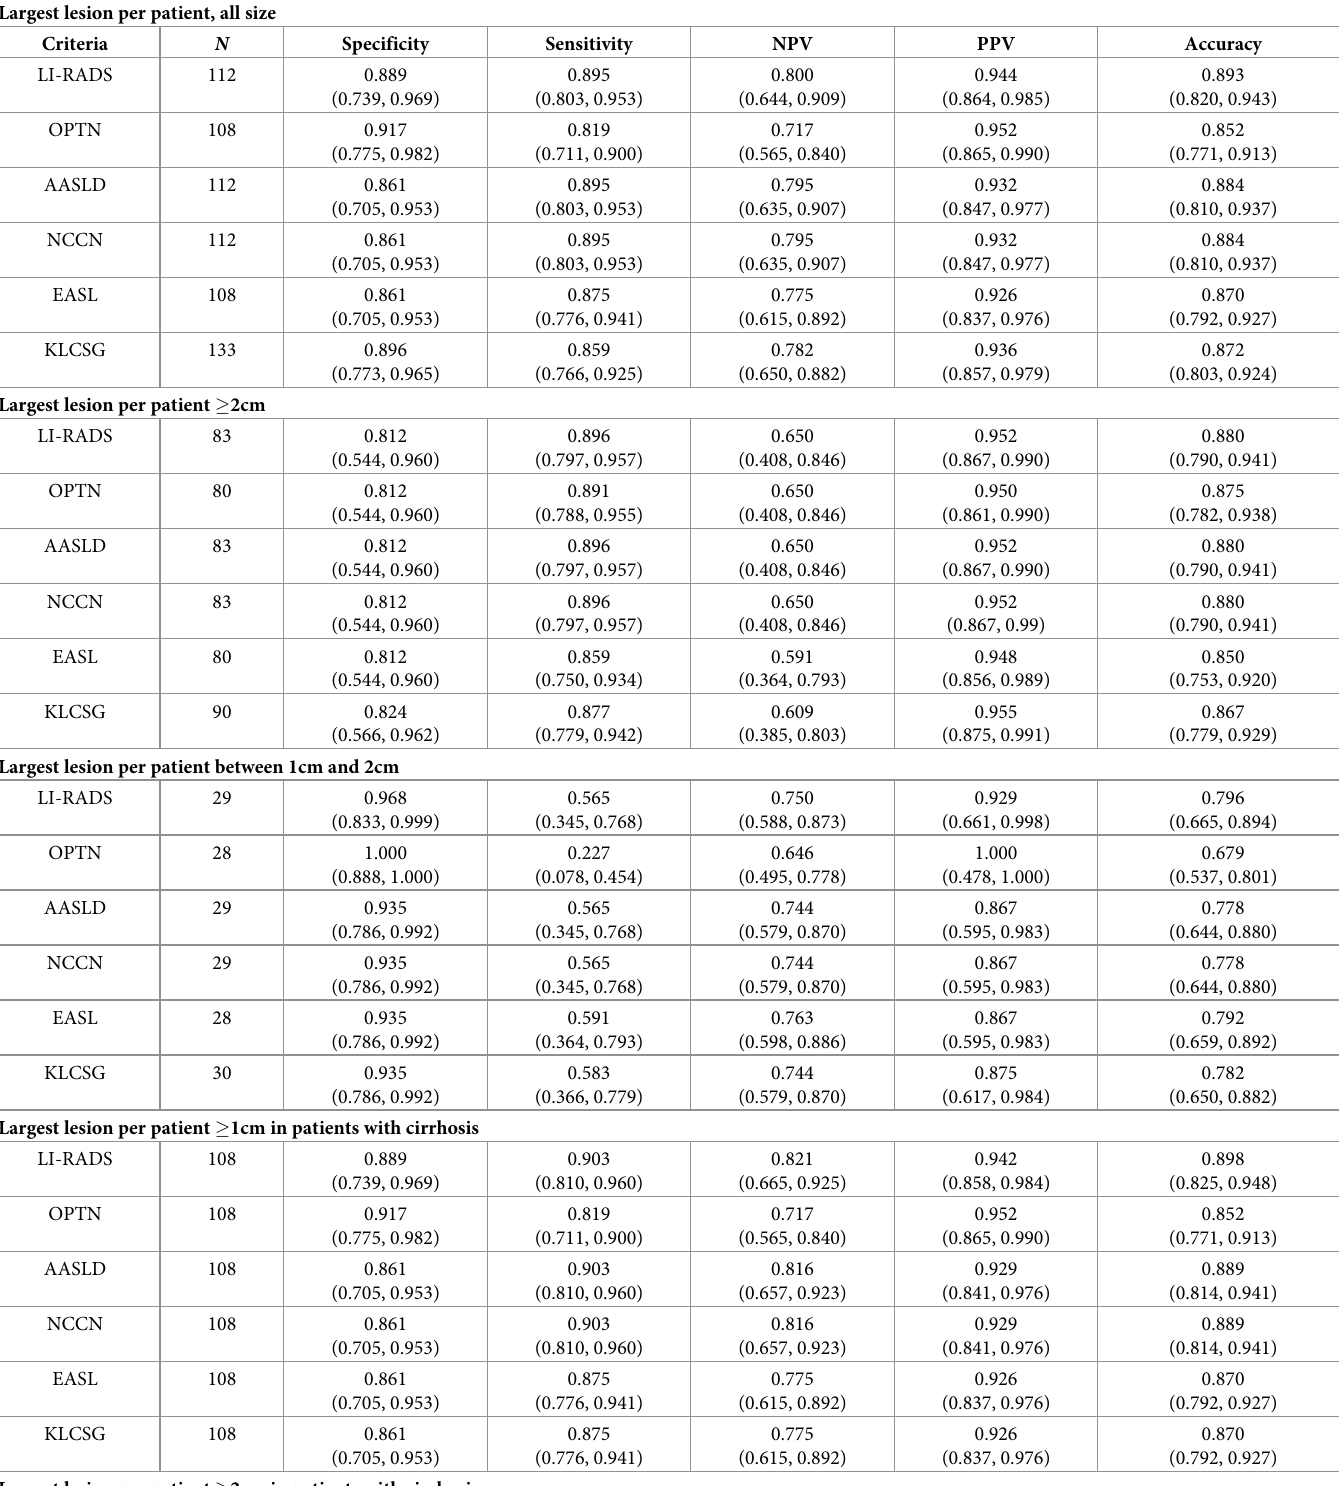
Table 3. Diagnostic performance of noninvasive diagnostic criteria. Largest lesion per patient, all